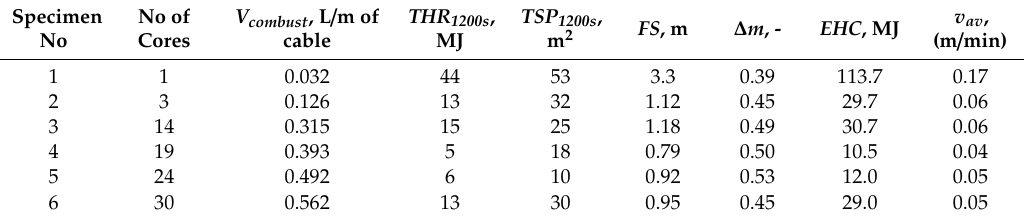
Table 3. Details of the experimental results for tested cables with the growing non-metallic volume V combust